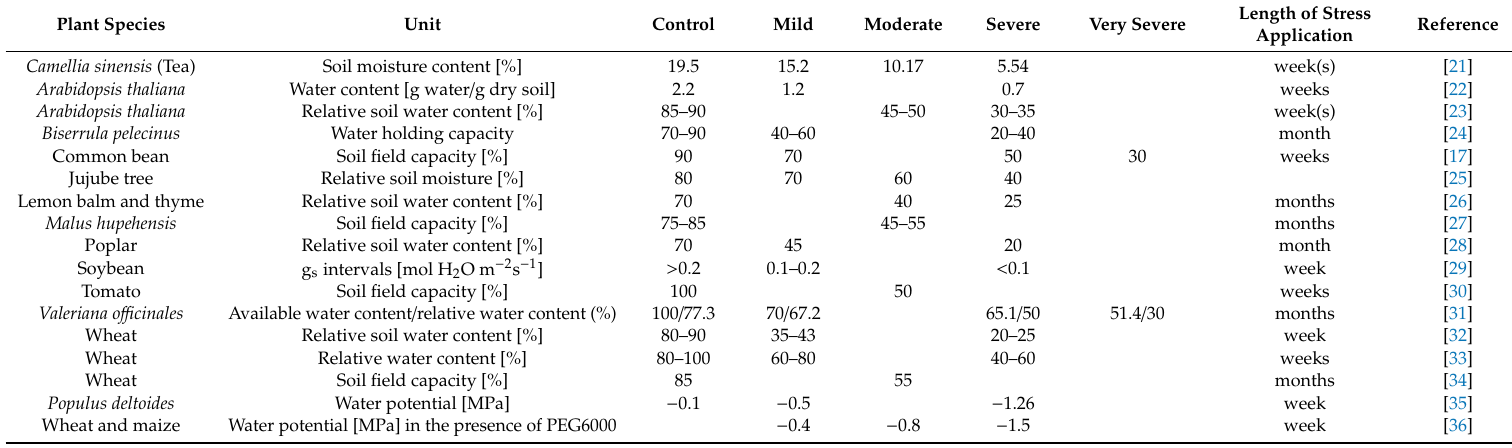
Table 1. Classification of drought stress by di ff erent units that describe the water availability for di ff erent species at the various stages of drought stress.